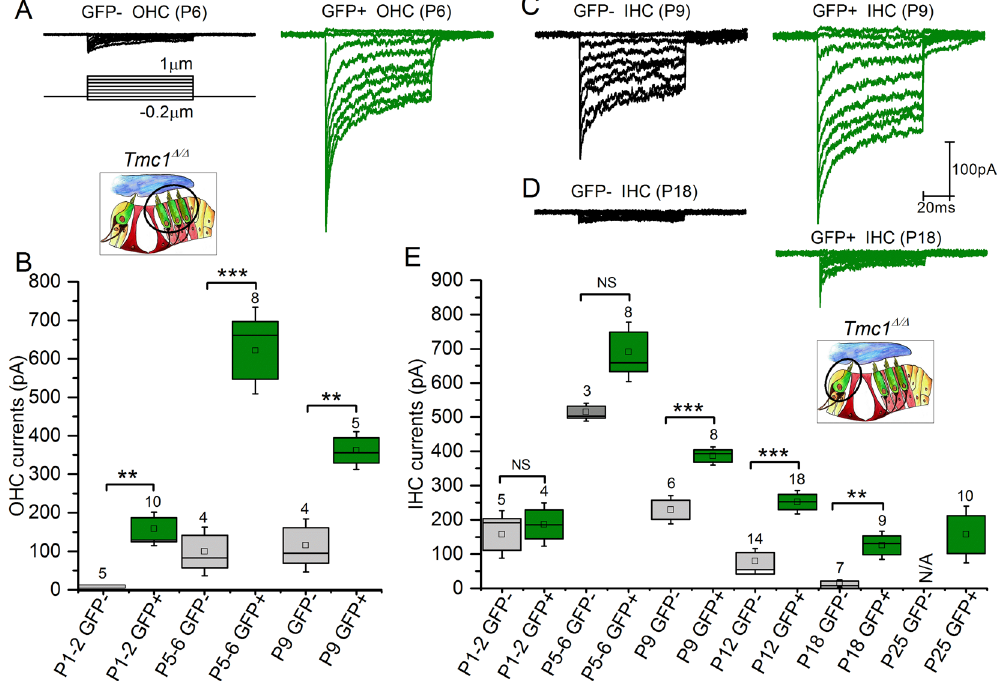
Figure 4. Sensory transduction in Rosa26 tm ( CAG-LSL-Tmc2-IRES-GFP ); Tmc1 Δ / Δ mice. ( A , B ) Sensory transduction currents were recorded from P1-9 GFP-positive and GFP-negative OHCs of Rosa26 tm ( CAG-LSL- Tmc2-IRES-GFP ) ;Gfi1 Cre/ + ;Tmc1 Δ / Δ mice. While absent in GFP-negative P1-P2 OHCs, large currents were recorded in P1-P2 GFP-positive cells. ( C – E) Currents were recorded from P1-P25 GFP-positive and P1-P18 GFP-negative IHCs. While currents decreased rapidly in amplitude after P6, large currents were measured GFP- positive cells as late as P25. Number of cells is indicated above the bar graphs. Mean ± S.E.M. *** p <